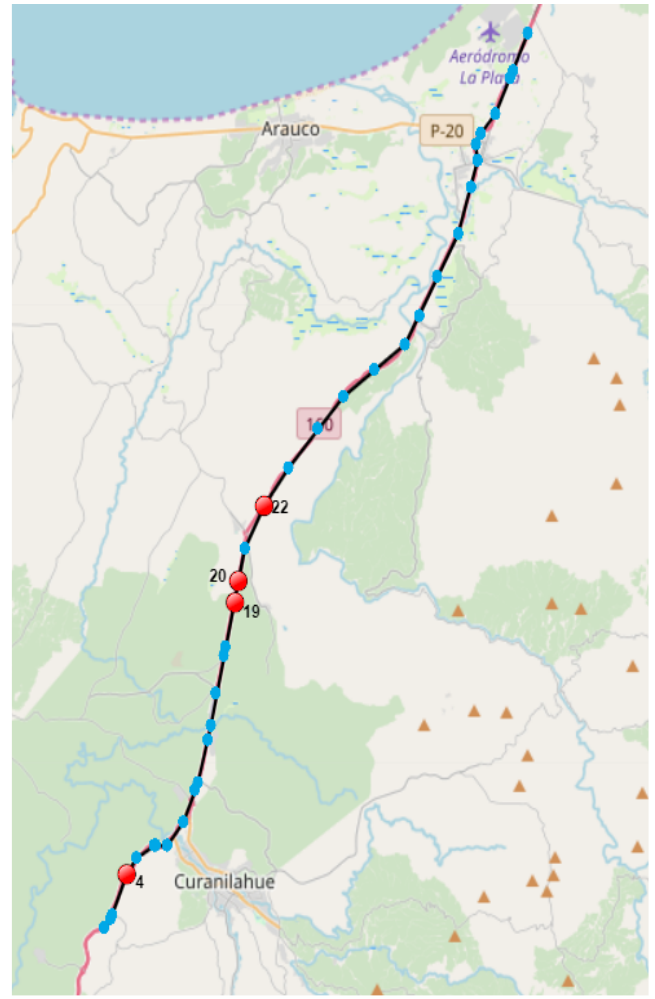
Figure 8. Example 2 of correctly detected outlier trajectory. The light blue points indicate GPS measurements of the complete trajectory, while the red points indicate the points with the highest reconstruction error according to the neural network. See detail in